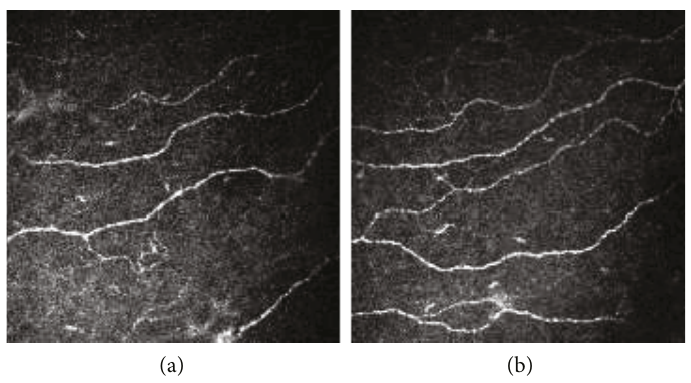
Figure 2: CCM images from a diabetic patient of group A at baseline (a) and follow-up (b).